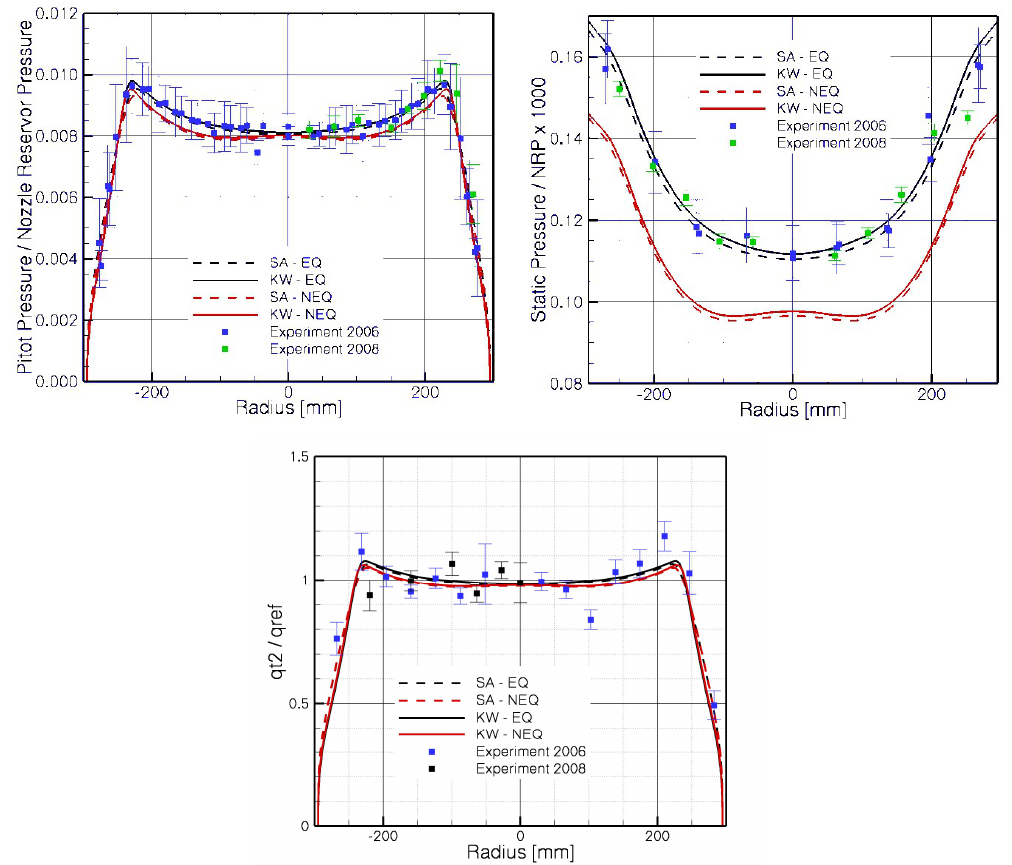
Figure 10: Comparison of measured and computed normalized Pitot pressure (left), static pressure (middle) and stagnation point heat flux distributions at the nozzle exit plane; NEQ: thermal non- equilibrium, EQ: thermal equilibrium, SA: Spalart-Allmaras turbulence model, KW: Wilcox k-ω turbulence model, NRP: Nozzle reservoir pressure (HEG operating condition